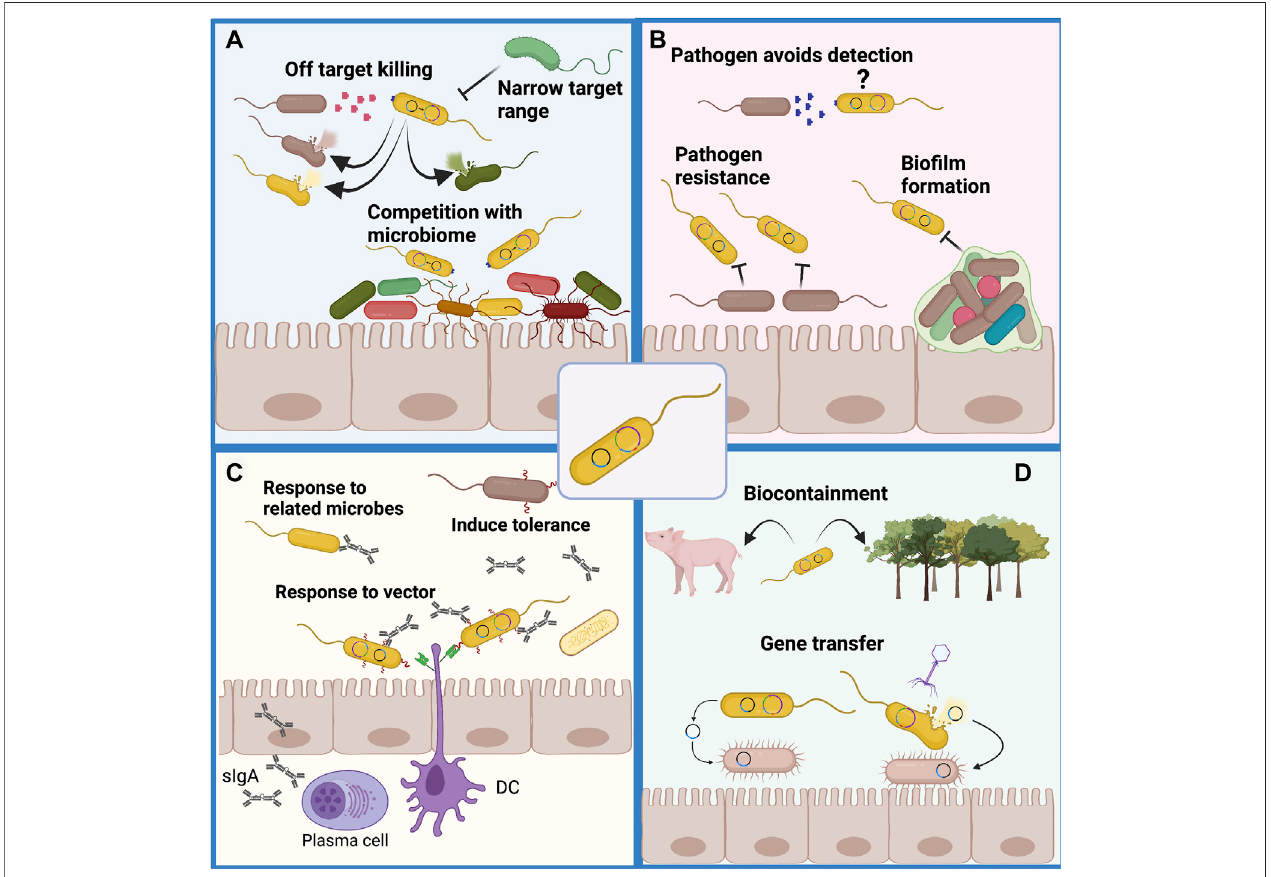
FIGURE 5 | Challenges remain to the wide-spread application of engineered probiotics. (A) Engineered probiotics must compete with the resident microbial species for nutrients to replicate and then act on pathogens. To compete effectively they must be as well adapted as the resident microbes but must not contribute to overwhelming the resident microbiota. The killing of pathogens must be precise to avoid off-target killing of resident microbiota which would increase dysbiosis. This imposesthelimitationthatthepathogenmustbespeci fi callyidenti fi edbeforetheapplicationoftheengineeredprobiotic. (B) Itislikelythatvariantsofanypathogen will arise that can avoid detection or develop resistance to the mechanism of killing used by the engineered probiotic. Bio fi lms that are formed by a variety of pathogens that colonize the gut pose a challenge for both detection and killing of the pathogen. (C) Administration of live-cell probiotic vaccines presents the concern of tolerant pathogens resistant to immune cell responses from vaccination. Live cell probiotics can also be recognized by immune cells as foreign microbes and targeted for cell death,therebydecreasingtheirviabilityandvaccineactions. (D) Containmentofanengineeredprobioticisimportantasitisdif fi culttopredicthowtheorganismwillactin different environments and there could be unexpected effects on animals, insects or plants for which the probiotic was not engineered. Even within the planned host environment transfer of genetic material to other organisms is a concern as this can occur through conjugation and direct transfer to bacteria as well as through phage mediated transduction and natural DNA uptake occurring upon cell lysis for any